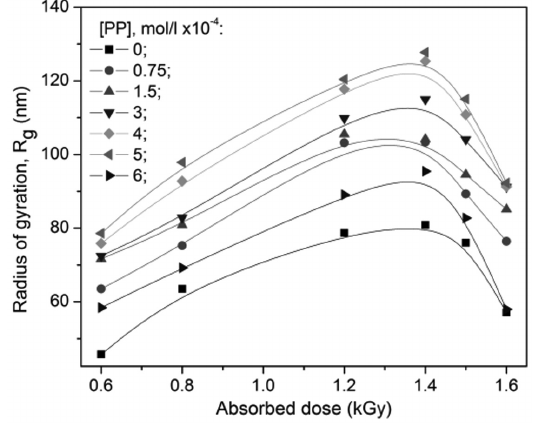
Figure 8. The effect of initiator concentration and EB absorbed dose on radius of gyration (R